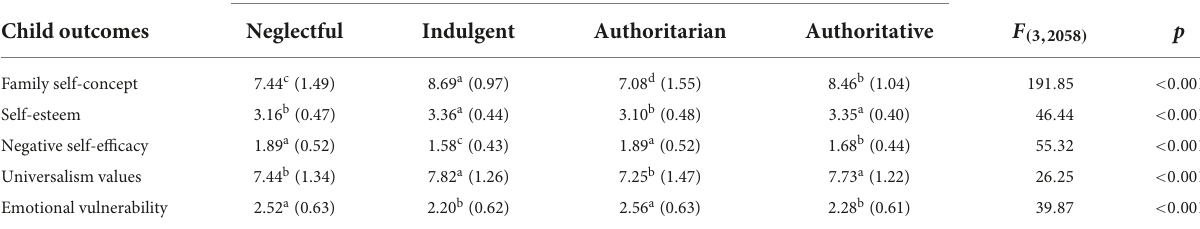
TABLE 3 Means, standard deviations, univariate F -values, and Bonferroni’s post-hoc analysis of parenting styles for self (family self-concept, self-esteem, and negative self-adequacy), universalism values, and emotional vulnerability by parenting styles.